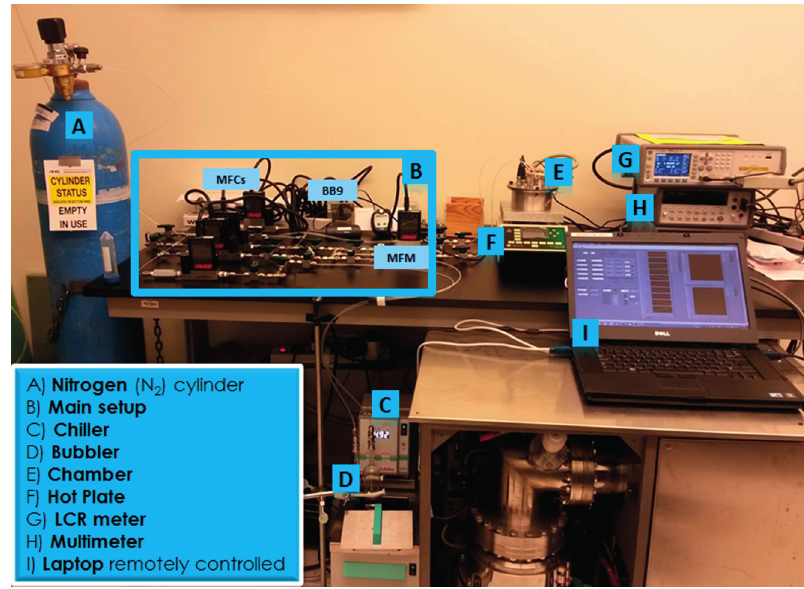
Figure 7. Implemented testing